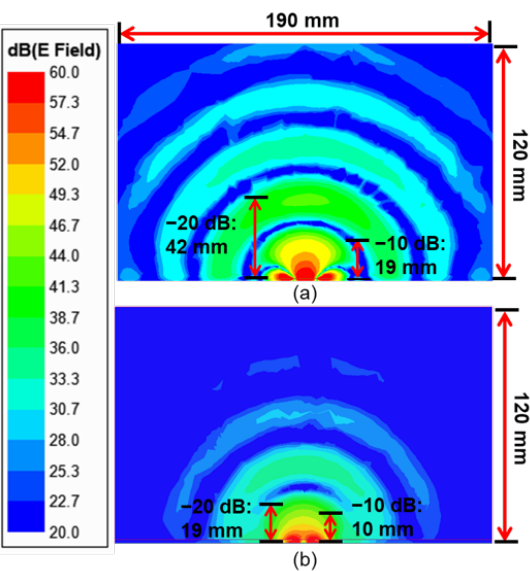
Figure 17. Electric fields in the vertical cross-section plane into the tissue for ( a ) the tuned phased loop array and ( b ) the single tuned loop